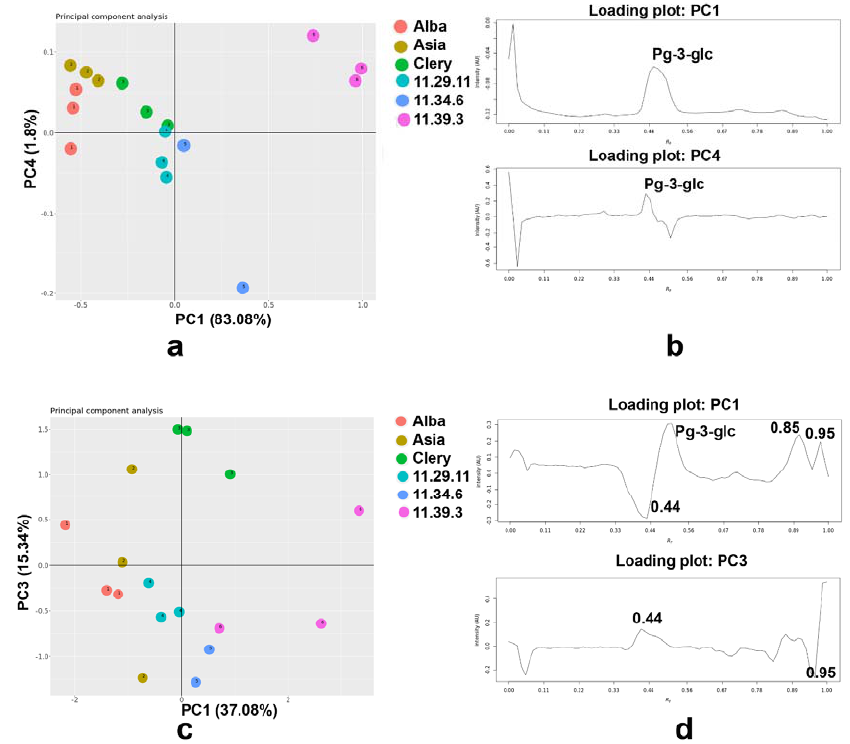
Figure 5. PCA based on the HPTLC fingerprint under white light illumination with ( a ) PCs score and ( b ) loading plot as well as under 254 nm with ( c ) PCs score and ( d ) loading plot. The PCA of the HPTLC– A. fischeri bioautograms (after grayscale HPTLC image fil ‐ tering, baseline correction, COW, SNV, and autoscaling) resulted in a four ‐ component model that explained 86.23% of the total data variance. PC1 described 42.68% of the total variability while PC2, PC3, and PC4 accounted for 25.88%, 12.65%, and 5.02%, respec ‐ tively. The PC scores of strawberries extracts were projected along with the three PC di ‐ rections, i.e ., for the 2D representation, the PC1 versus PC3 was selected (Figure 6a). The separation between promising breeding materials and three usual sorts of strawberries was evident (Figure 6a). However, the two 11.34.6 extracts overlapped with the 11.29.11 extracts. There was no clear separation between the usual strawberry cultivars because of the similar bioautographic pattern (Figure 6a). Inspection of the loading plot points to the Pg ‐ 3 ‐ glc, and compounds with hR F values at 60 and 91 as a characteristic marker with potential Gram ‐ positive antimicrobial activity (Figure 6b). PC2 accounted 7.83%, while PC3 accounted 4.95% of the total variability. PCs score plots based on white light illumi ‐ nation (PC1 versus PC2 and PC1 versus PC3) and 254 nm (PC1 versus PC2 and PC1 versus PC4) were presented in Figure S3.